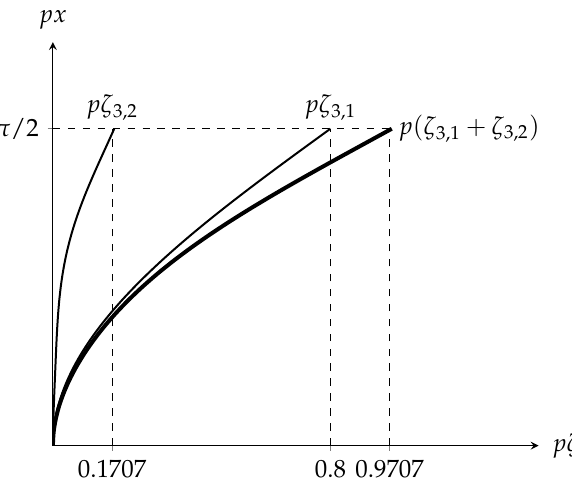
Figure 7. Different mode shapes of the buckled elastic cantilever beam for the fundamental mode of